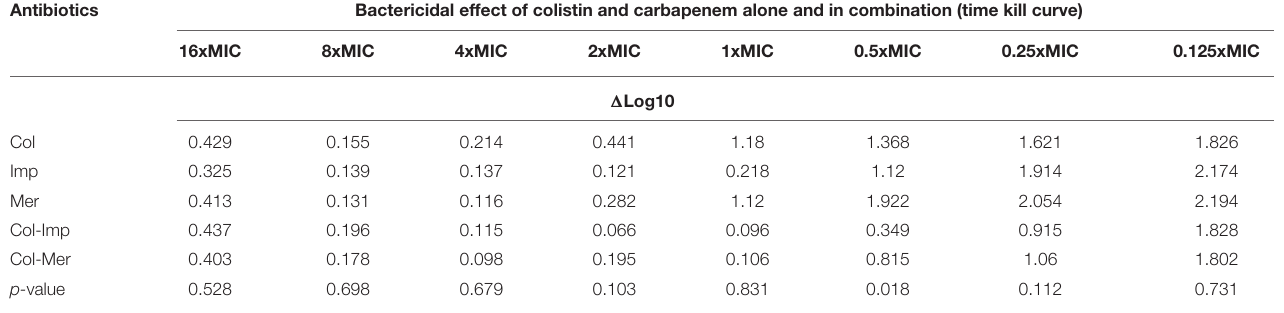
TABLE 4 | 1 Log10 values of the cfu/ml of the Acinetobacter isolates obtained by the time kill curve assays after incubation, as compared to the initial inoculum. Antibiotics